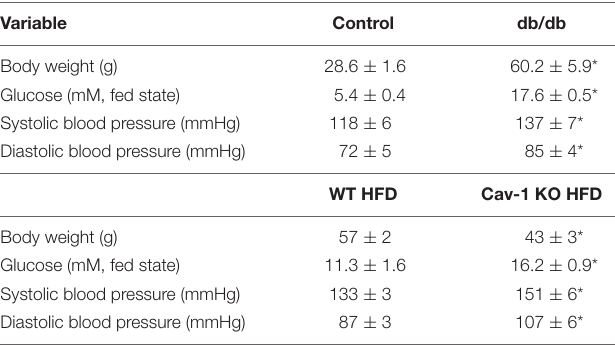
TABLE 2 | Characteristics of db/db mice, wild type and caveolin-1 knockout mice with HFD.